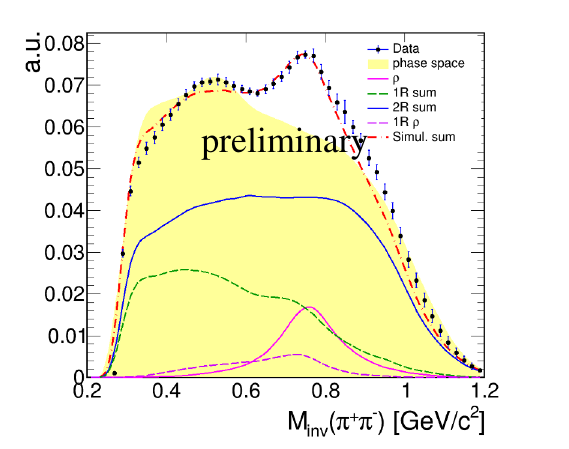
Figure 3: ( π + π − ) invariant mass distribution after kinematical cuts, compared to simulations: direct ρ (pink), double resonance (blue), one resonance (dashed green). The ρ production from resonance decay (dashed purple). The phase space (yellow